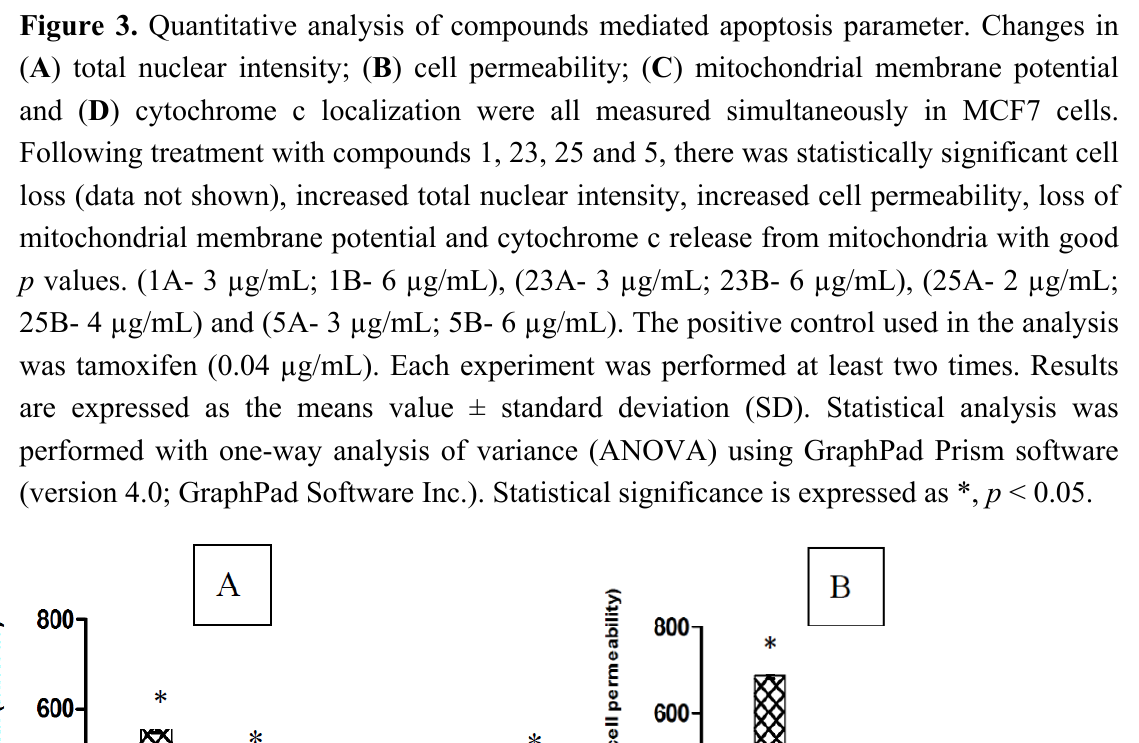
Figure 3. Quantitative analysis of compounds mediated apoptosis parameter. Changes